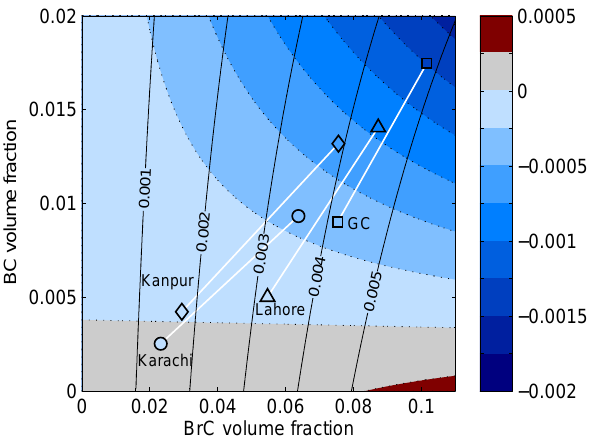
Figure 6. Difference between the imaginary index with and without BrC included at 440nm (solid isolines) and at RNIR wavelengths (by color bar and dotted isolines) as a function of BC and BrC vol- ume fractions. Monthly mean values of BC and BrC volume frac- tions are shown for each site by symbols and lines for 2 months: April with the name of the site next to it and November at the other end of the line.